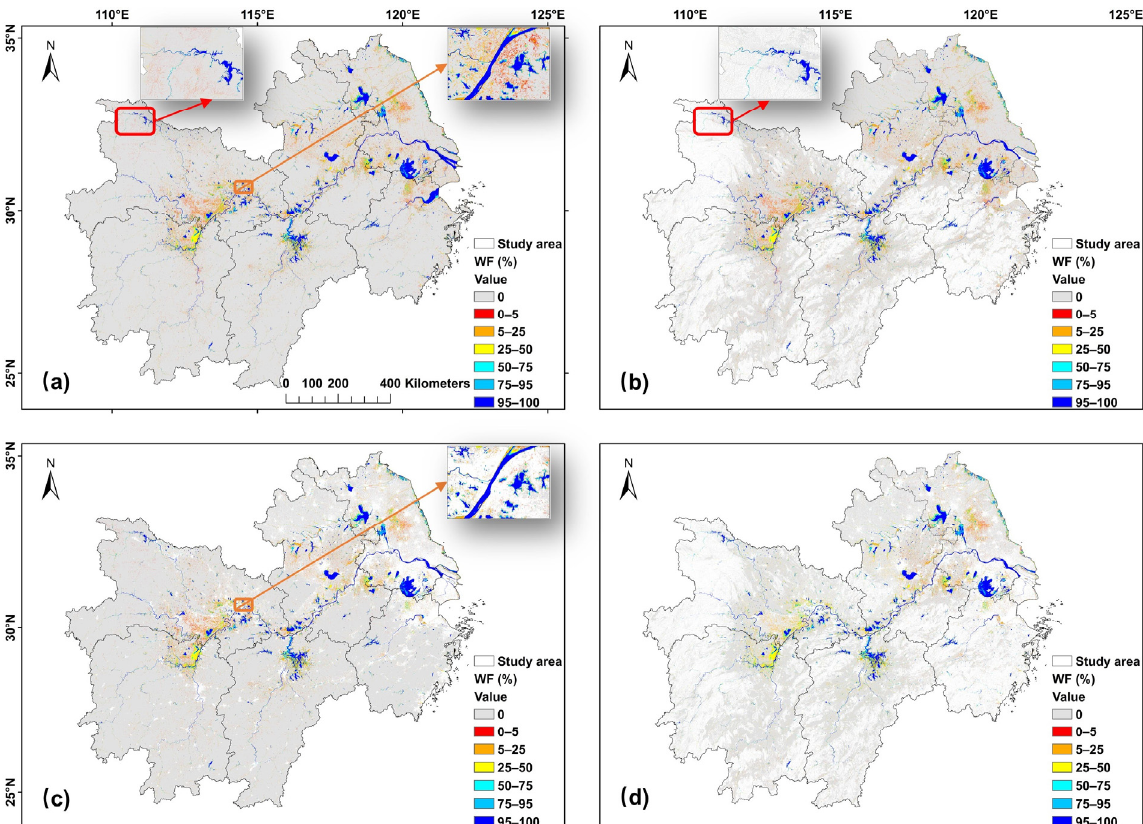
Figure 5. The flow map of the water extraction method in MLYP in 2020. ( a ) The water extraction map of N-MVI index method; ( b ) the water map of Figure 5a masked with DEM data; ( c ) the water map of Figure 5a and the impervious surface data were intersected and inverted; ( d ) the final generated water map.